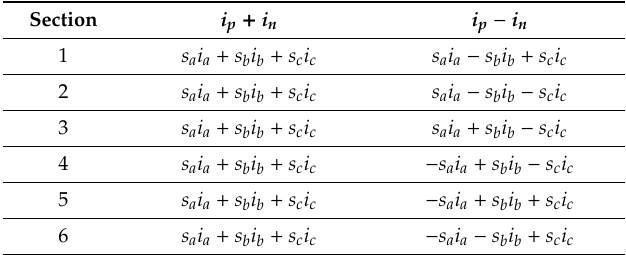
Table 2. Instantaneous values of i p + i n and i p − i n